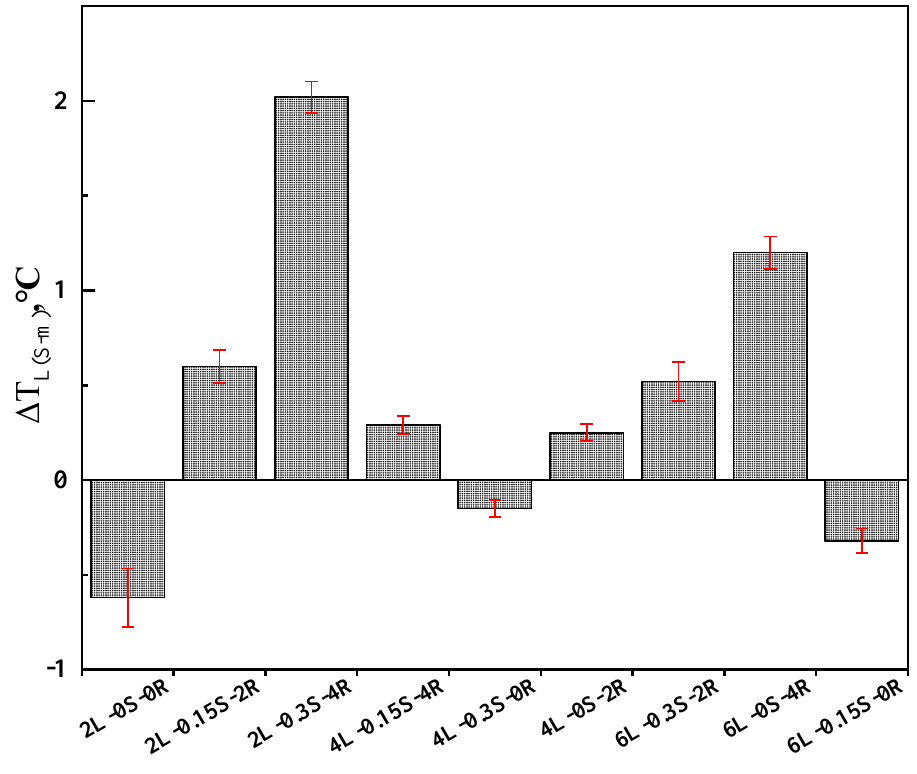
∆ T Figure 5. ΔT c of SBS-modified asphalt. Figure 5. c of SBS‑modified